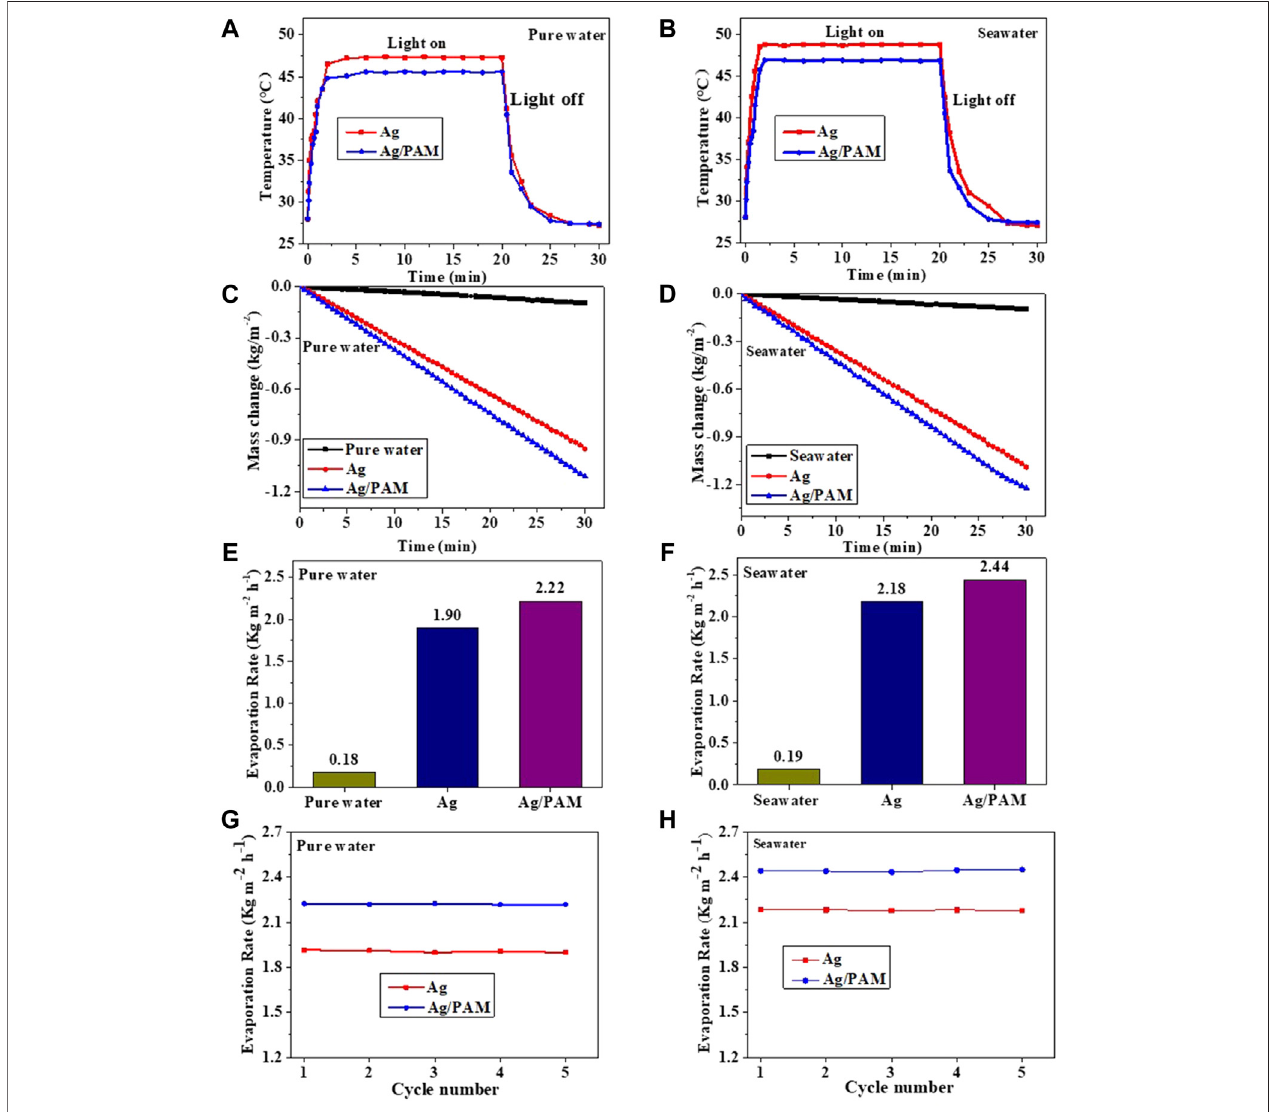
FIGURE 4 | Ag and Ag/PAM materials under one sun irradiation: Time – temperature pro fi les of (A) Ag and (B) Ag/PAM; (C) Mass loss Ag and (D) Ag/PAM; Evaporation rate of (E) Ag and (F) Ag/PAM; Repeated evaporation rate of (G) Ag and (H) Ag/PAM.